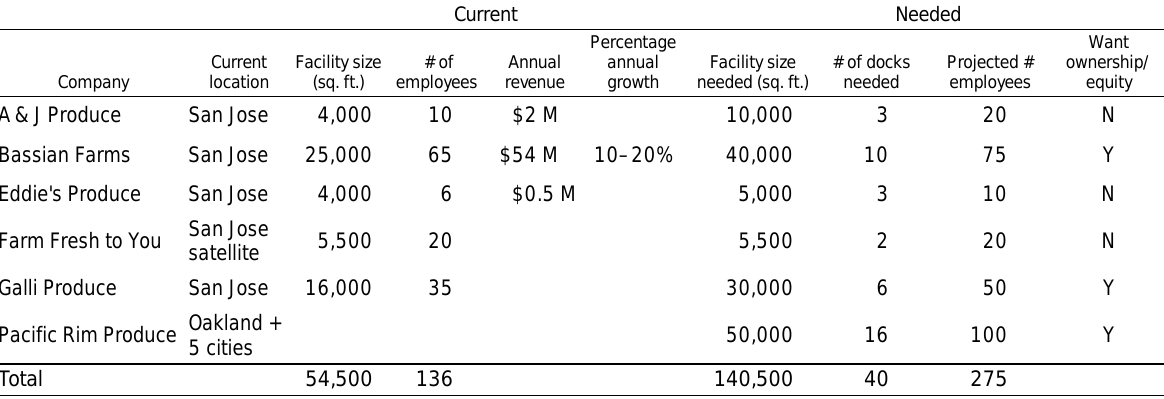
Table 5. Summary of Demand for a Wholesale Food Market from Distributors and Processors (all currency in